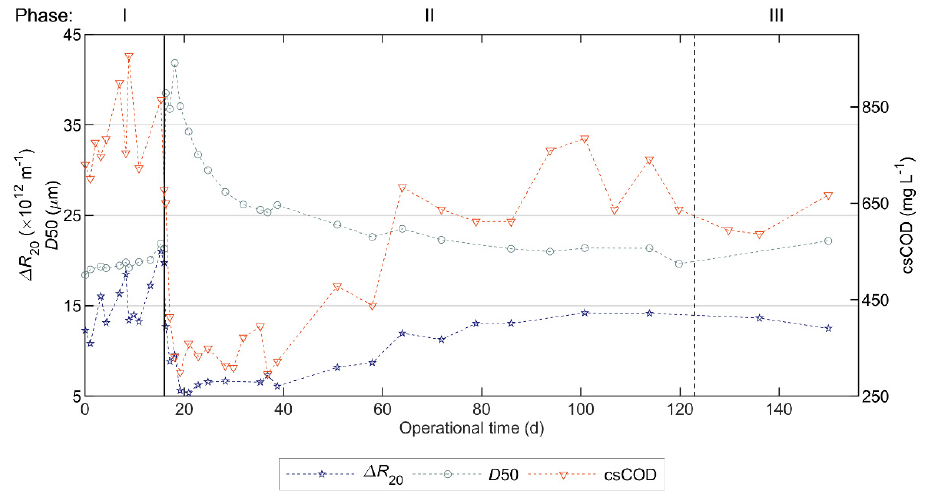
Figure 3. Sludge characteristics during the operational period of the pilot AnMBR dosed with flux enhancer: filterability expressed as ∆ R 20 ( ∆ R 20 is inversely related with filterability), floc size expressed as 50th percentiles of volume-based particle size distribution ( D 50 ), and submicron COD concentration (csCOD). A pulse-dosage of Adifloc KD451 achieving 50 mg L − 1 was performed on day 16 (black continuous vertical line), and sludge was withdrawn on day 123 (black dotted vertical line).